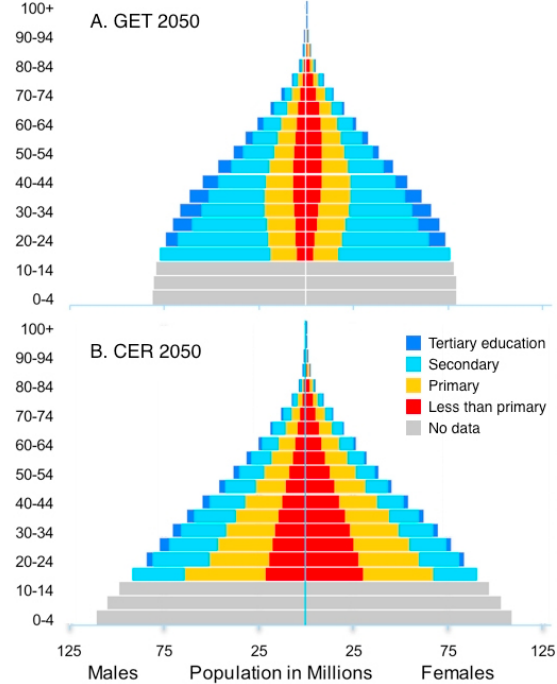
Fig. 2 . Age pyramids by level of education for Sub-Saharan Africa, for 2050. A – under the global education trends (GET) scenario. B – under the constant enrollment rates (CER)